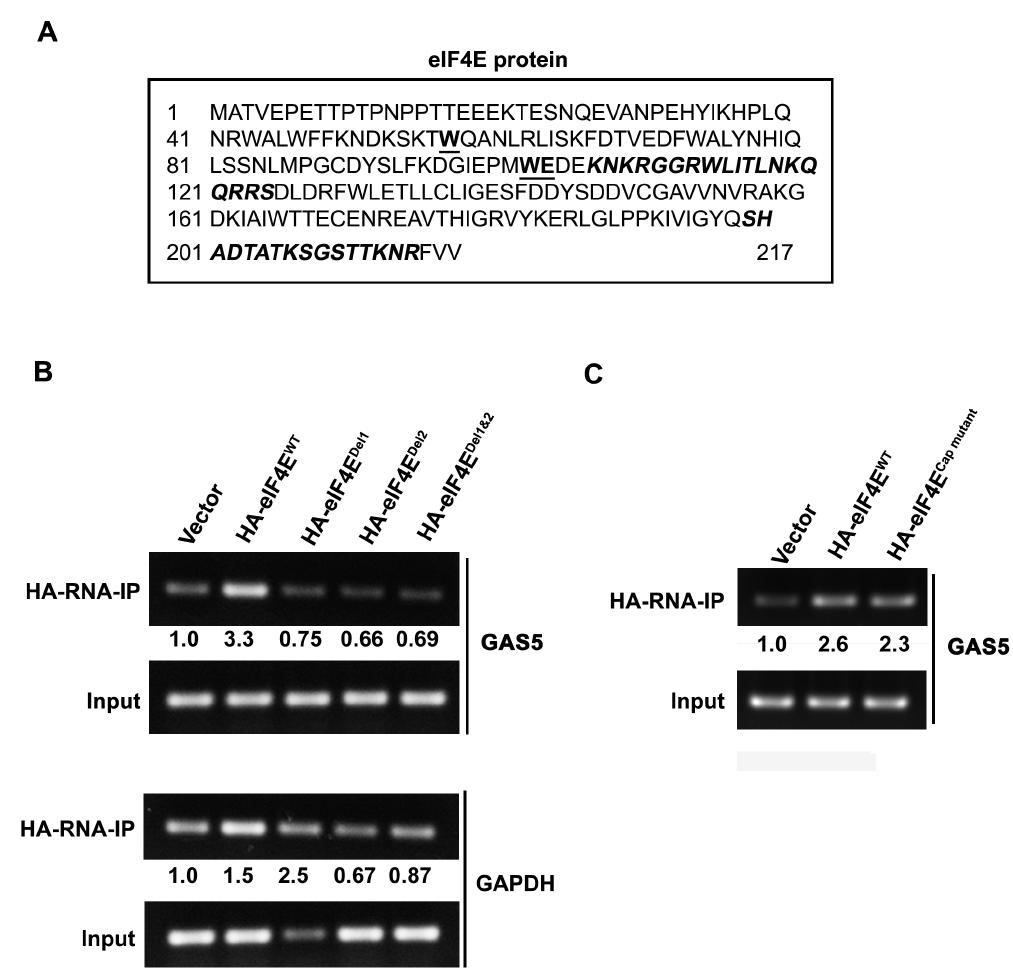
Figure 2. GAS5 binds to eIF4E through RNA binding motifs. ( A ) RNA binding motifs, which are italic and bold, in the eIF4E protein were predicted with 2 web-based tools, BindN and PPRInt. The motif, W56, W102 and E103 for m7G binding is bold and underlined. N-terminally located sequence is motif-1 and the C-terminal one is motif-2. ( B-C ) GAS5 RNA was detected by RT-PCR after RNA-IP assay using HA antibody in the cells transfected with ( B ) RNA binding deletion mutants (HA-eIF4E Del1 , HA-eIF4E Del2 and HA-eIF4E Del1&2) and ( C ) cap binding mutant (HA-eIF4E cap mutant ). GAPDH was used as a control.